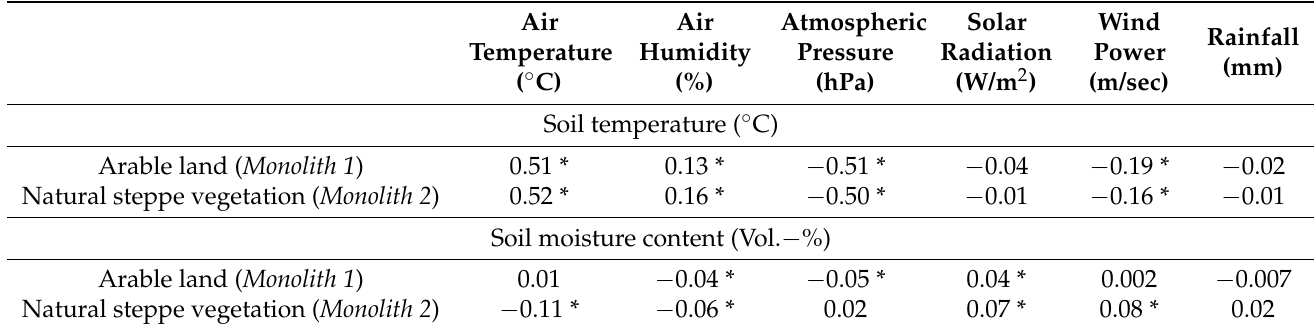
Table 1. The Spearman’s rank correlation between climate parameters (WS) and soil indicators measured at 30